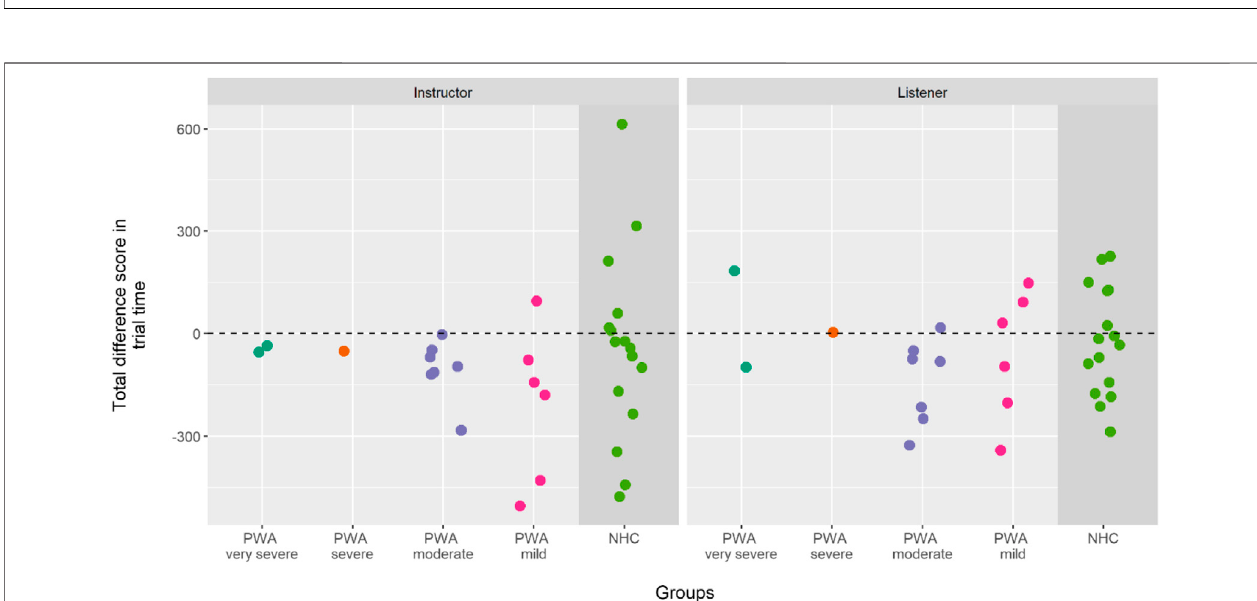
FIGURE 3 | Boxplots showing total trial time by condition and group, for each role (instructor/listener).